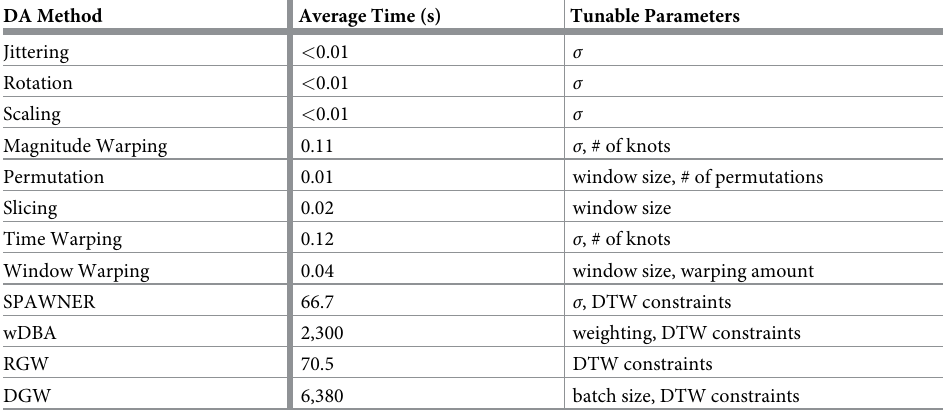
Table 4. Algorithm comparison with average augmentation time per dataset and tunable